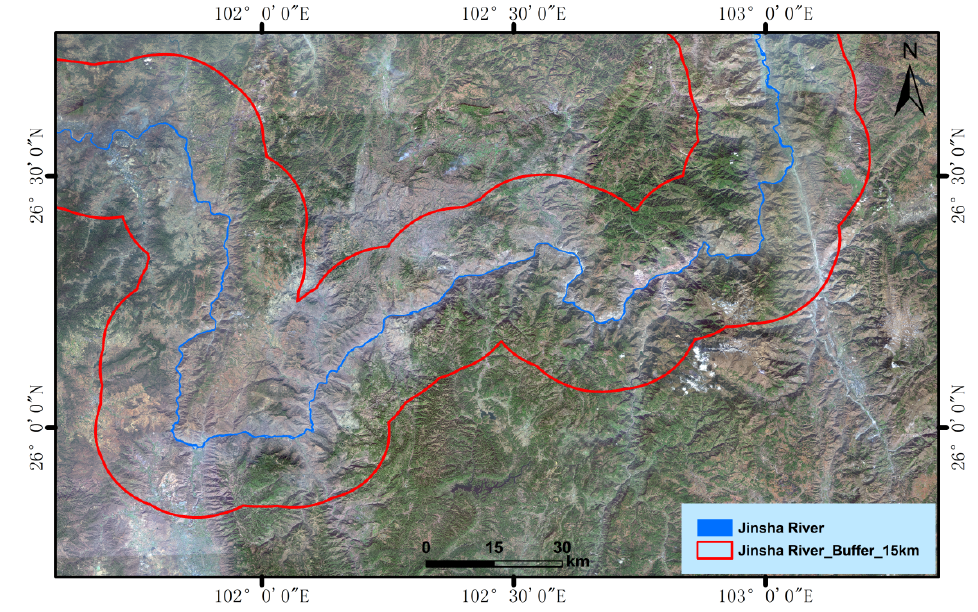
Figure 1. GF-1 Satellite of the study area in vegetation growing season in 2019.